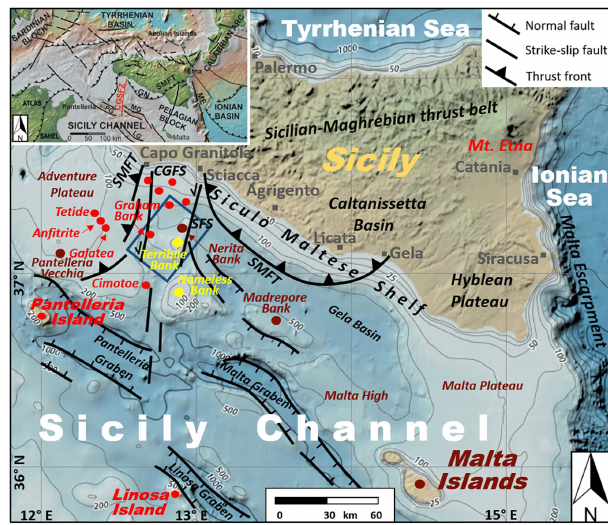
Figure 6. Shaded relief bathymetric map of the northern portion of the Sicilian Channel (from the GEBCO, General Bathymetric Chart of the Oceans, Digital Atlas). The red, brown and yellow cir- cles indicate the location of the volcanic centres, sedimentary banks and sedimentary banks with scattered volcanic manifestations on top (from Cavallaro and Coltelli,